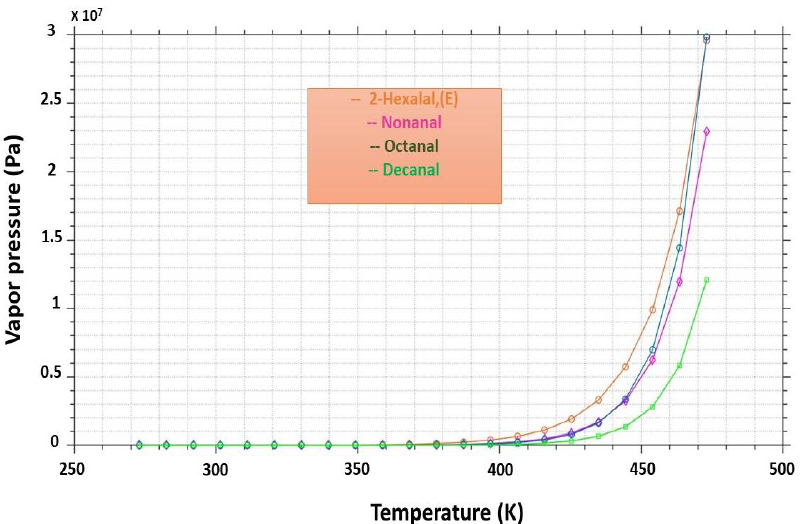
Figure 4. Variation of vapor pressure “volatility” for the major volatile’s molecules in the crude palm oil versus temperature “applied pressure” during MFA treatment.